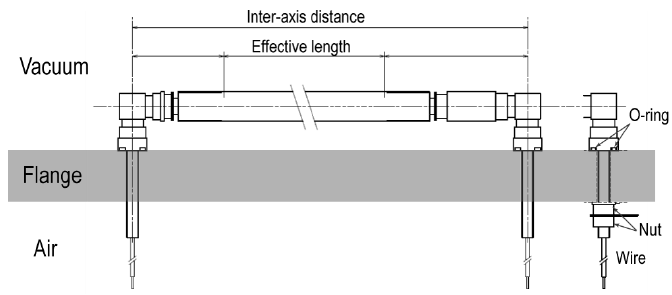
Figure 2. Schematic picture of 3 He PSD tube.